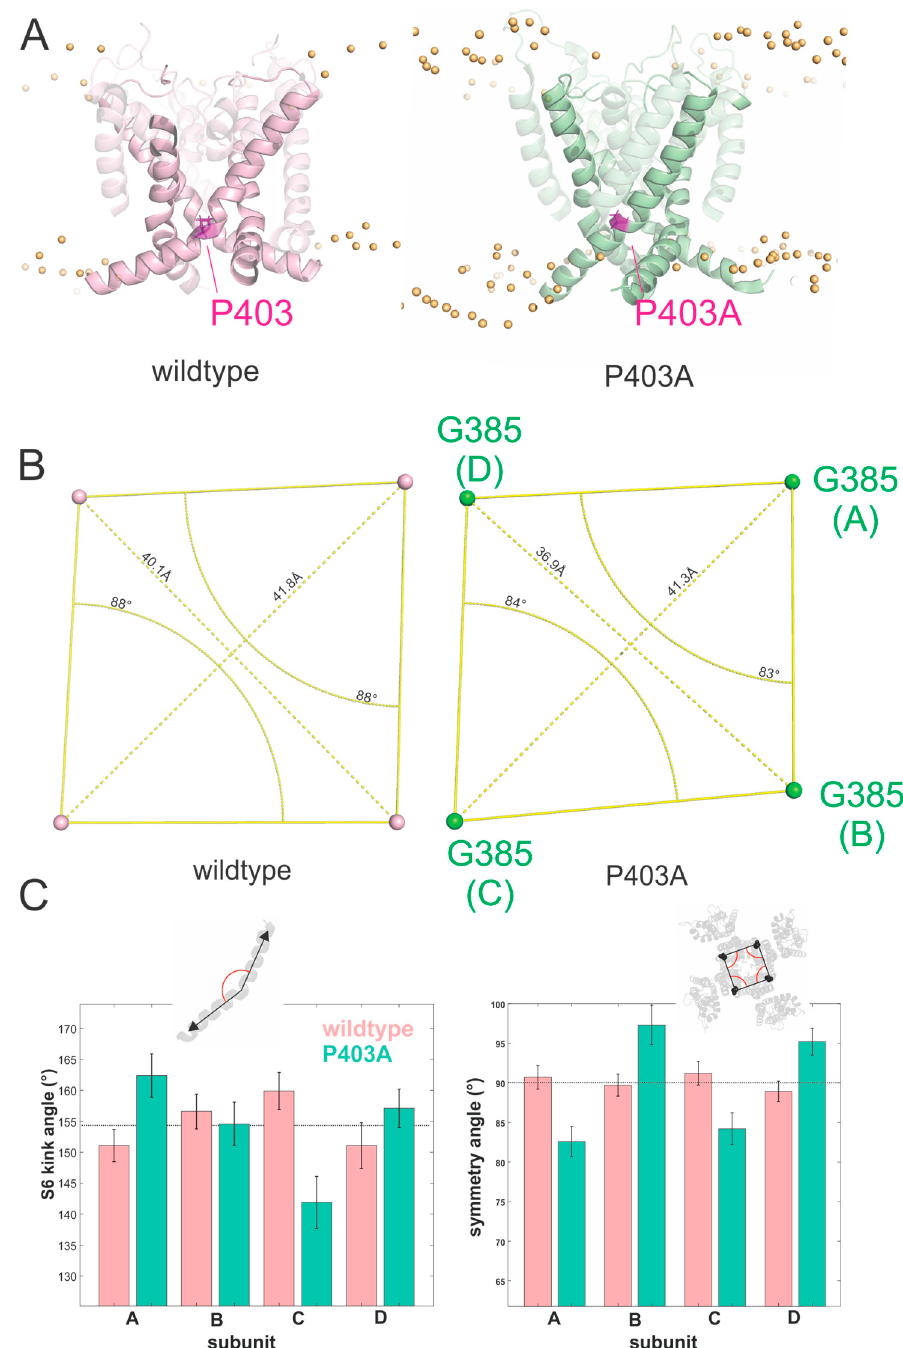
Figure 5. ( A ) Side view of the homology model of the Kv1.1 channel built upon the crystal structure of Kv1.2/2.1 chimera showing the localization of the P403 residue and P403A mutation. P403A is highlighted in magenta. ( B ) Loss of symmetry of wildtype and P403A measured at the top of S6 (position G385). ( C ) Measure of the S6 kink angle ( left ) and symmetry angle ( right ) for the four subunits of WT and P403A channels. The kink angle of the S6 was measured as the angle between the helix axis of the S6 above and below the PVP/A-motif. The symmetry angles are formed by the vectors from G385 of one subunit to the G385 of the two neighboring subunits. Values are given as mean ± SD of the values measured every 0.1 ns over the last 50 ns.